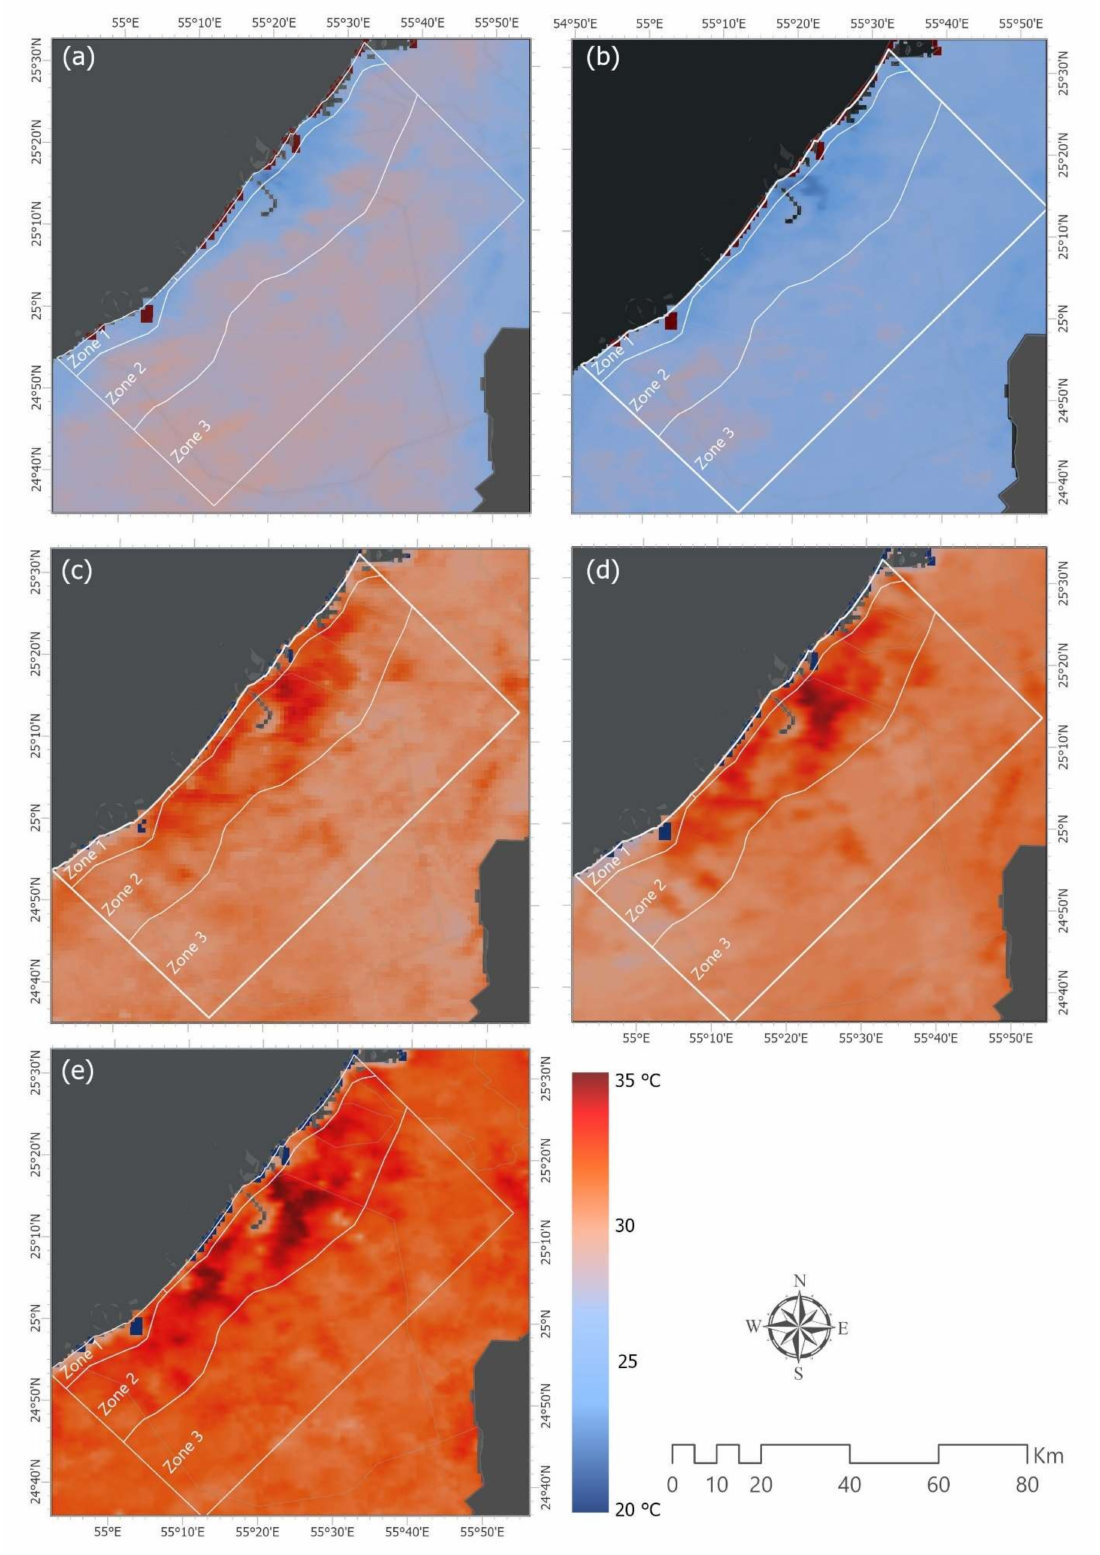
Figure 7. Temporal Evolution of LST nighttime over the UAE in August: ( a ) 2000; ( b ) 2005; ( c )